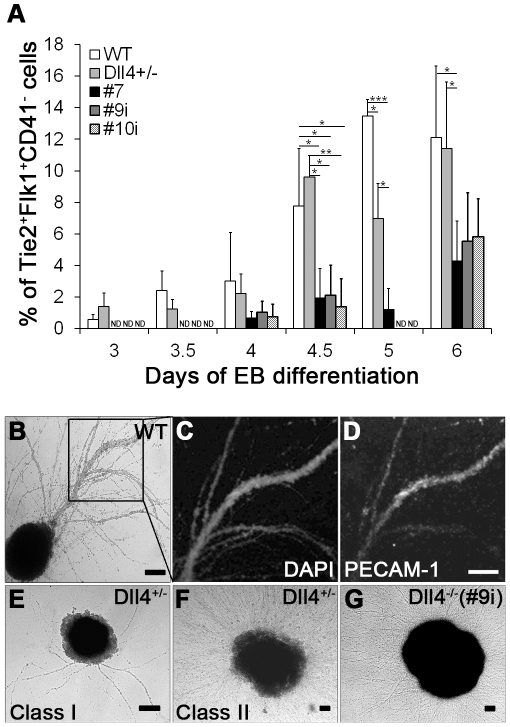
Endothelial differentiation and remodelling defects in Dll4 mutant EBs.(A) Flow cytometry analysis of Tie2+Flk1+CD41− cells in WT, Dll4+/− and Dll4−/− EBs from day 3 to day 6 of differentiation. (B) Bright field image of a WT EB, at day 25 of differentiation, showing sprouts in methylcellulose medium. (C–D) Inset shows the correspondent confocal images for DAPI (C) and PECAM-1 (D) staining of EB sprouts. (E–G) Representative bright field images of Dll4+/− (class I and II sprouts; E–F) and Dll4−/− (clone #9i; G) EBs with endothelial sprouts, cultured for 25 days in methylcellulose medium. Scale bar represents 100 µm. ND not determined. *P<.05, **P<.01, ***P<.001.